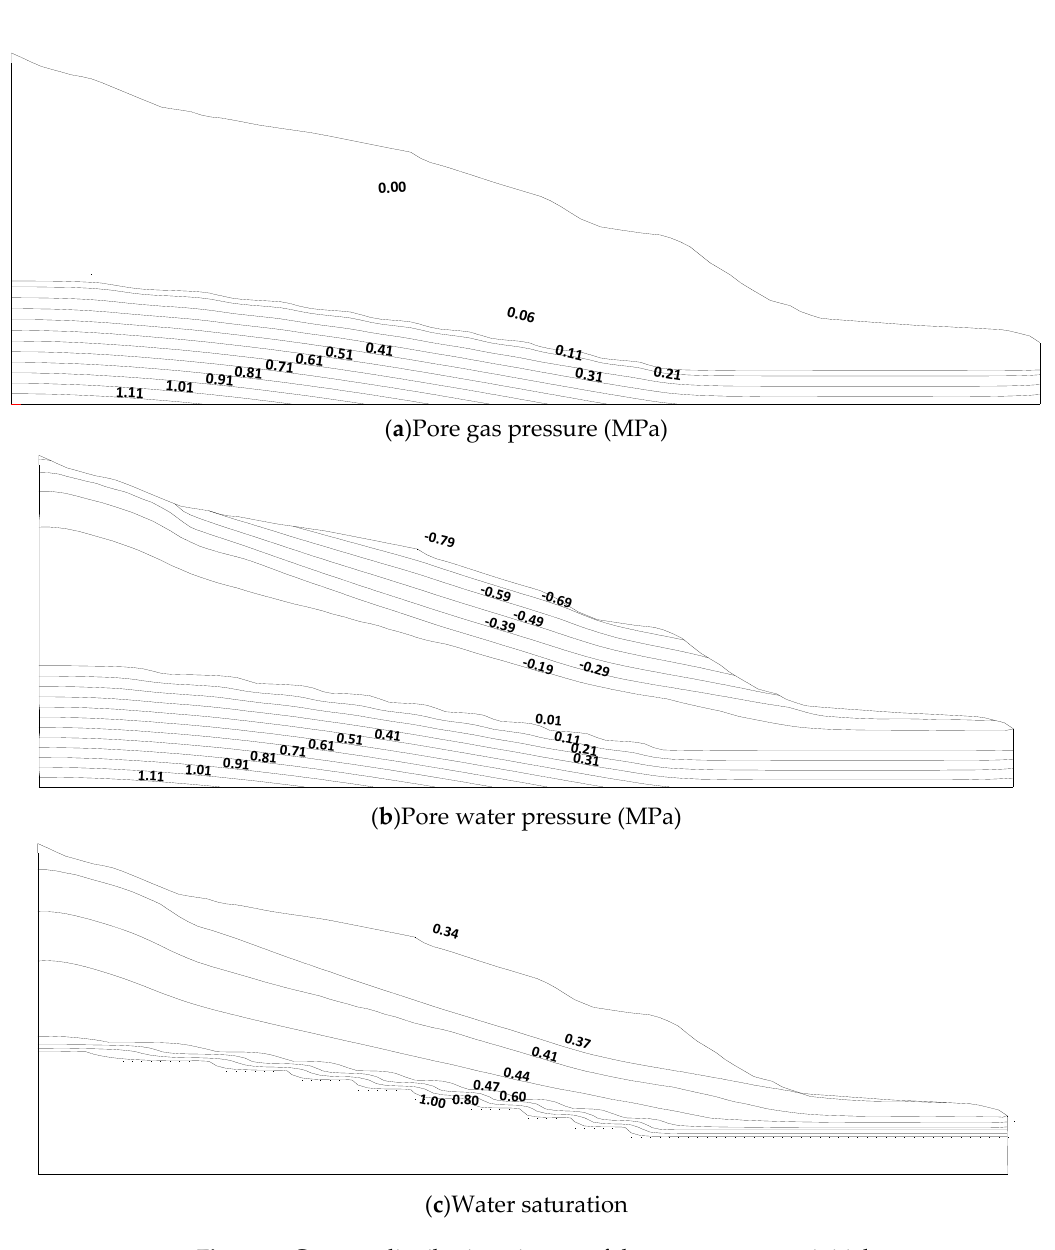
Figure 9. Contour distribution pictures of three parameters at initial status.